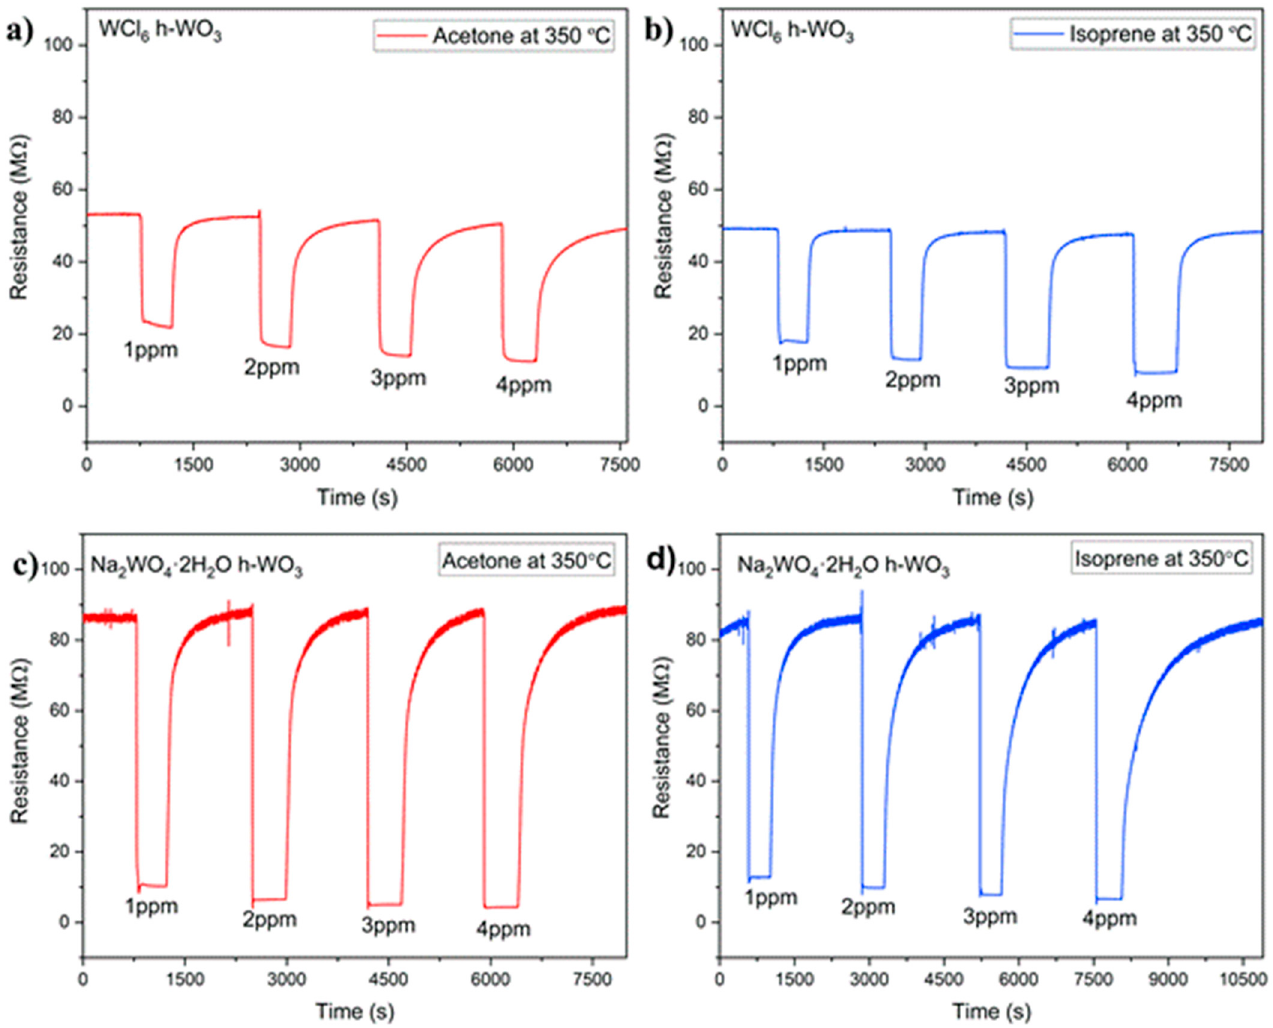
Figure 3. Sensing response of the WCl 6 h - WO 3 sample towards 1, 2, 3, and 4 ppm acetone ( a ) and isoprene ( b ) at 350 ◦ C. Sensing response of the Na 2 WO 4 · 2 H 2 O h - WO 3 sample towards 1, 2, 3, and 4 ppm acetone ( c ) and isoprene ( d ) at 350 ◦ C.